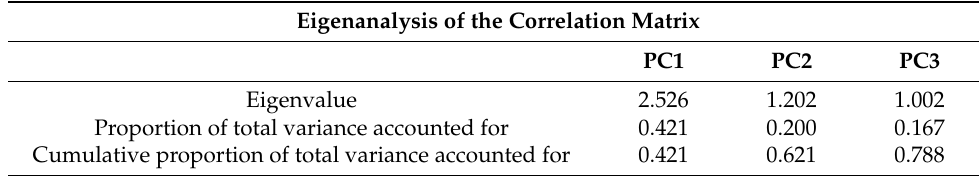
Table 6. Results from the principal component analysis of Z SST , Z SOI , and Z SAM .